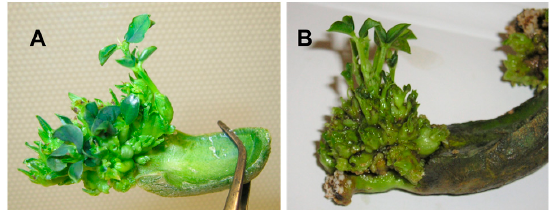
Figure 2. Adventitious shoot primordia induction in the proximal region of the de-embryonated cotyledons of Arachis hypogaea L. cv. Virginia, when cultured in liquid MS medium containing ( A ) 110 µM BA or ( B ) 10 µM TDZ for two weeks. Table 3. De novo regeneration of Arachis hypogaea L. cv. Virginia shoots on de-embryonated cotyle- dons, when cultured on semi-solid MS media.